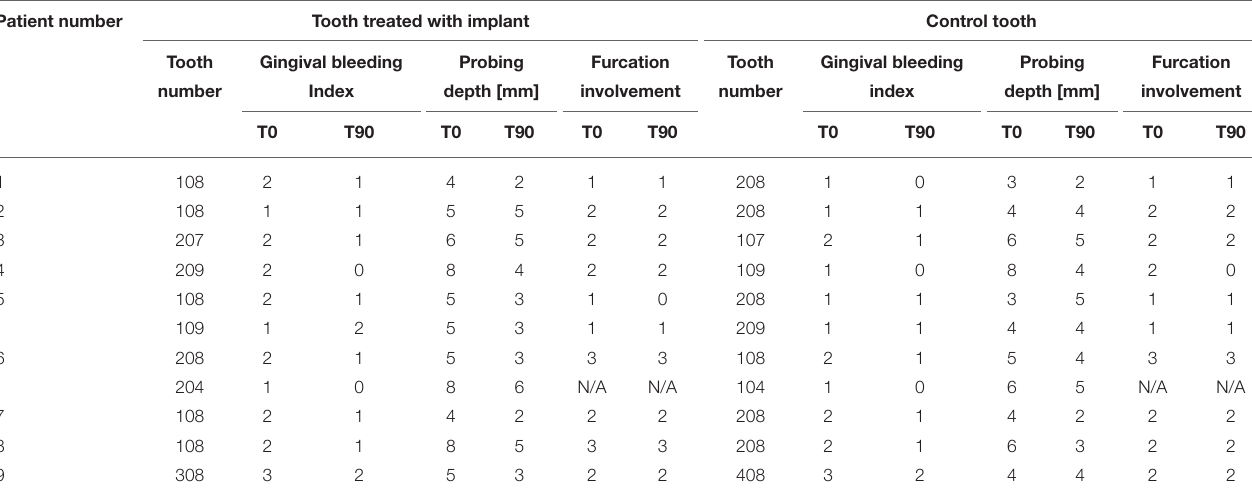
TABLE 1 | Clinical parameters of the treated teeth at the presentation (T0) and 3-month recheck (T90). Patient